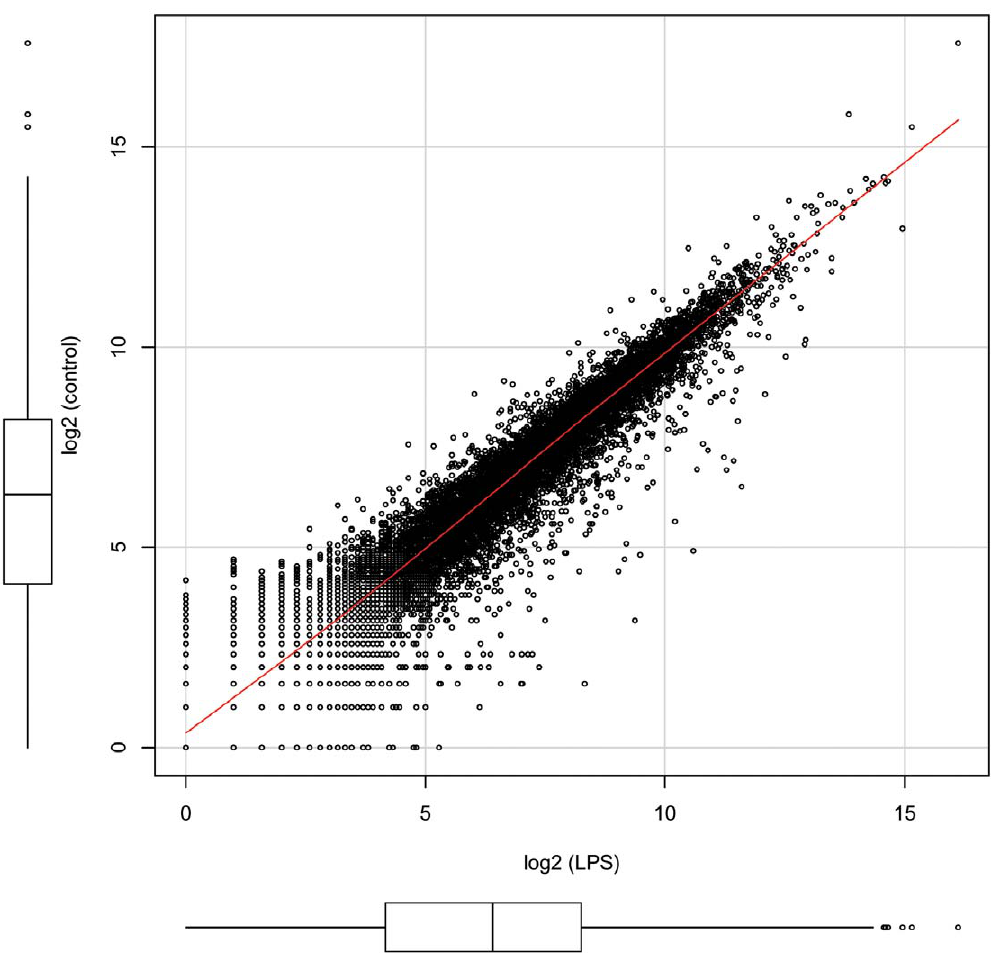
Figure 1. Gene expression in naive and immune-challenged beetles. All reads were aligned to predicted genes and are shown as log2 values derived from cDNA of naı¨ve and LPS-challenged animals, respectively. The linear correlation is indicated by a red line (F-test, P, , 2.2 6 10 2 16 ).